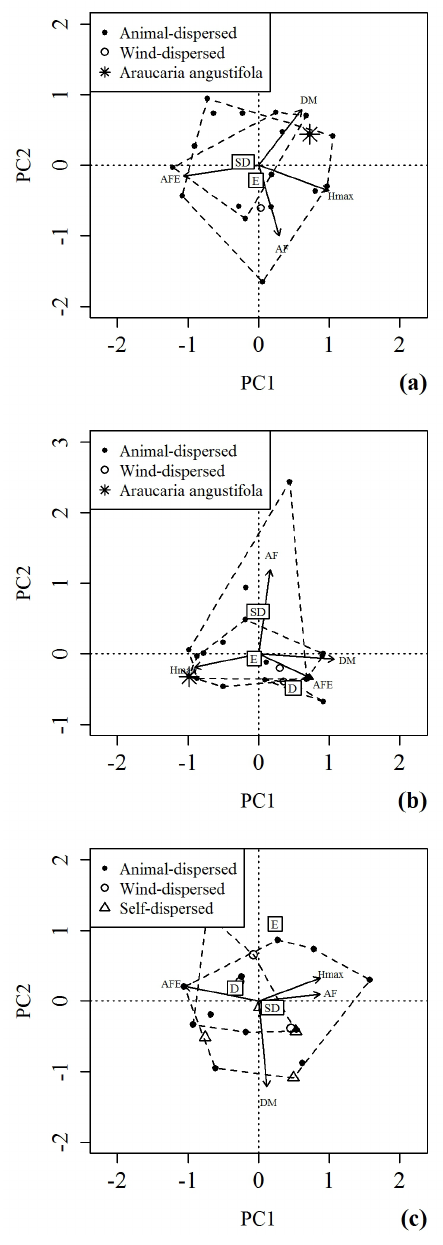
Figure 2 - Ordinations produced by Principal Component Analysis of species according to their functional traits in araucaria forest areas, over an altitudinal gradient ( a – 1,600 m asl; b – 900 m asl and c – 700 m asl), along the southern plateau of Santa Catarina, Brazil comparison. Dashed lines connect species with the same deciduousness condition (SD = semi-deciduous; D = deciduous; E = evergreen; DM = Basic Wood Density; AFE = Specific Leaf Area; Hmax = Maximum Potential Height; AF = Leaf